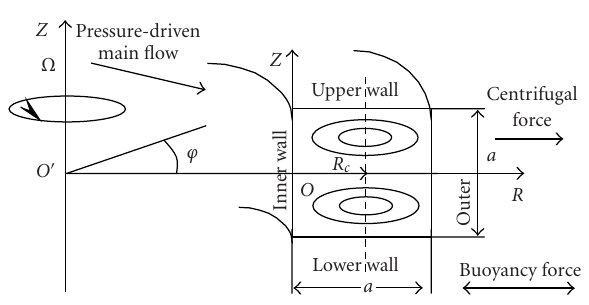
Figure 1: Physical problem and coordinating